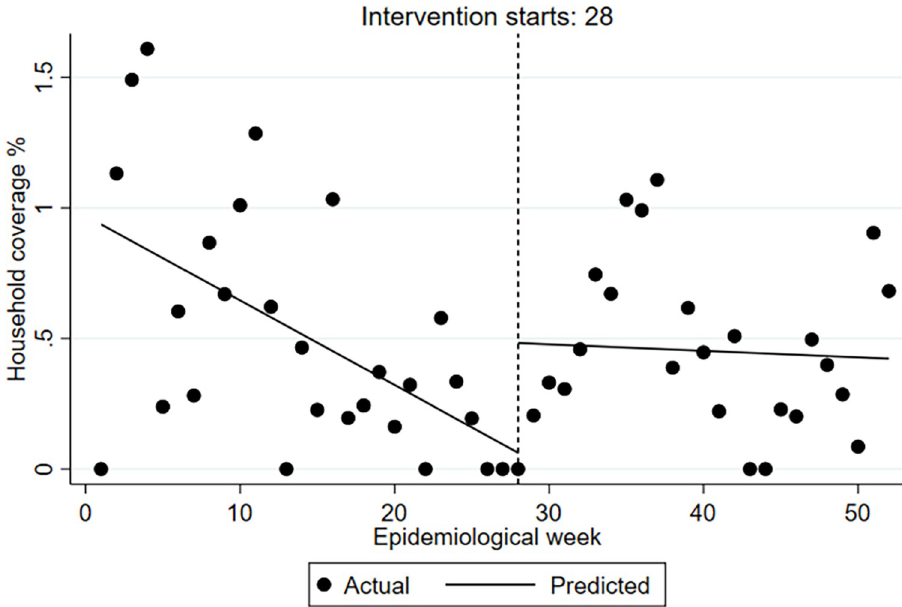
Fig 3. Segmented time-series of household coverage % with larval control at baseline (pre-alarm signal period), at the week (28) of alarm signal and post-alarm signal period. One example of outbreak districts is presented. (San Nicolas).